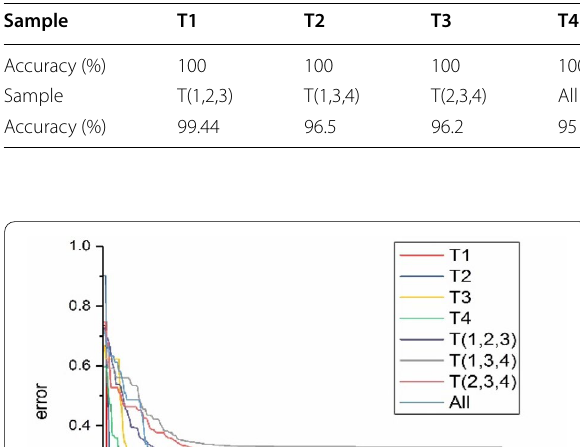
Table 2 Test results of each sample set (case 1)